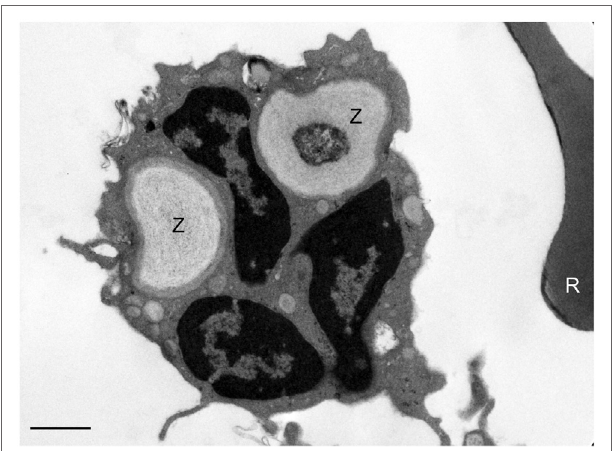
FIGURe 3 | Assessment of phagocytosis of zymosan reporter particles by electron microscopy. An electron micrograph illustrating zymosan particles (Z) inside a neutrophil 60 min post incubation of the reporter particles with whole blood. A red blood cell (R) can be seen to the right of the neutrophil. This image is representative and indicates that the zymosan particles are effectively internalized by cells in suspension. The scale bar = 1